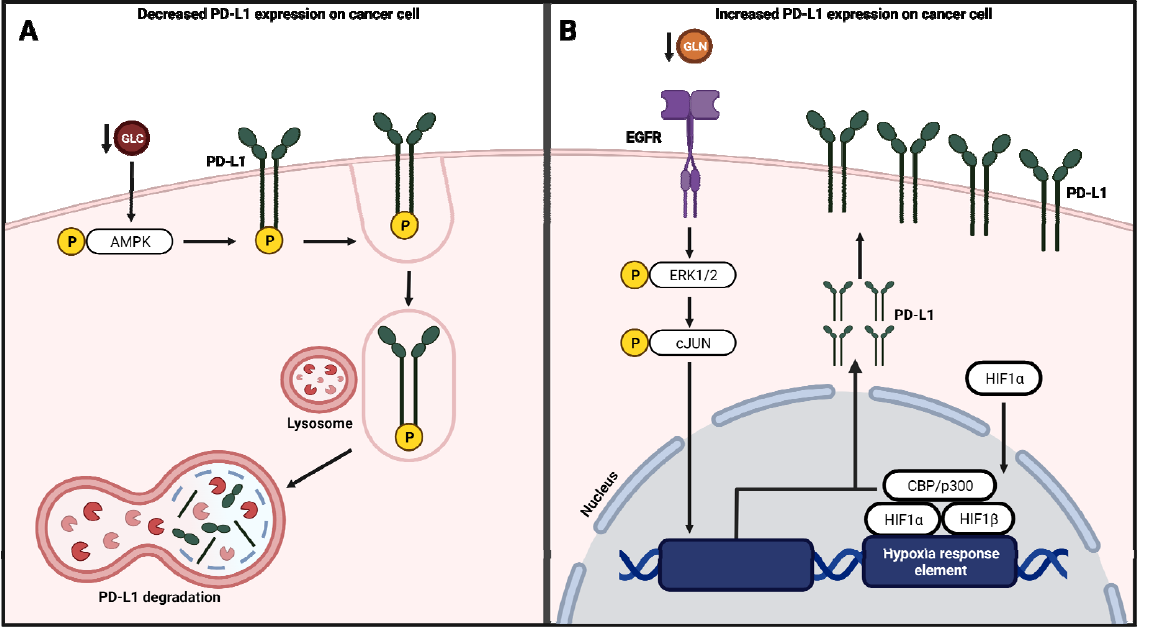
Figure 4. Metabolic signaling and regulation of PD-L1 expression. ( A ) Glucose (GLU) starvation and activation of AMPK results in the degradation of PD-L1 and a decrease in its expression. ( B ) Glu- tamine (GLN) depletion activates EGFR and MAPK signaling, resulting in the upregulation of PD-L1 during hypoxia.